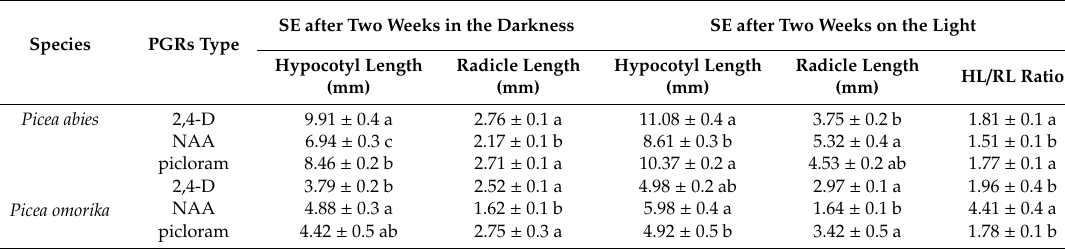
Table 5. Hypocotyl and radicle length of somatic embryos after two weeks of growth in the darkness and hypocotyl and radicle length and ratio of hypocotyl length to radicle length after two weeks of growth in light of germinated P. abies and P. omorika somatic embryos in relationship to the PGR type used during the induction of the ET lines. Di ff erent letters within columns indicate statistically significant di ff erences between means for PGRs type within species ( p <